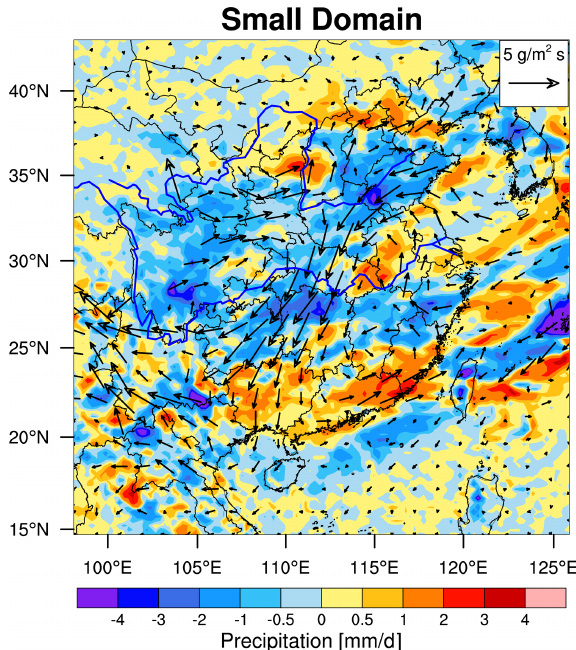
Figure 8. The spatial distributions of aerosol-induced difference (CTRL-CLEAN) of precipitation and moisture transport at 700hPa averaged for June and July 2017 from the small-domain simula-